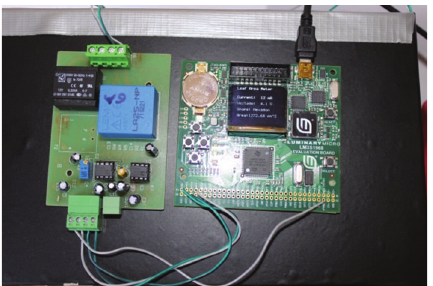
Figure 9: Sample leaf area measurement.